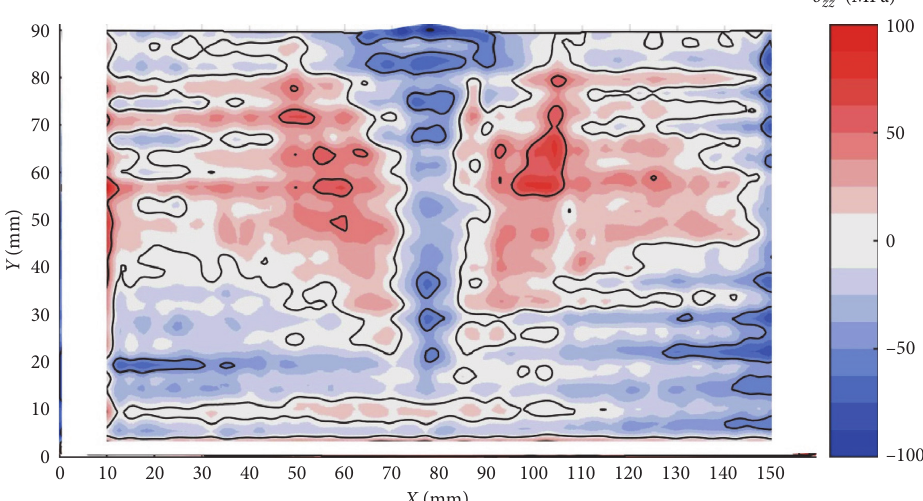
Figure 13: Longitudinal residual stress distributions in the CA6NM EB welds after